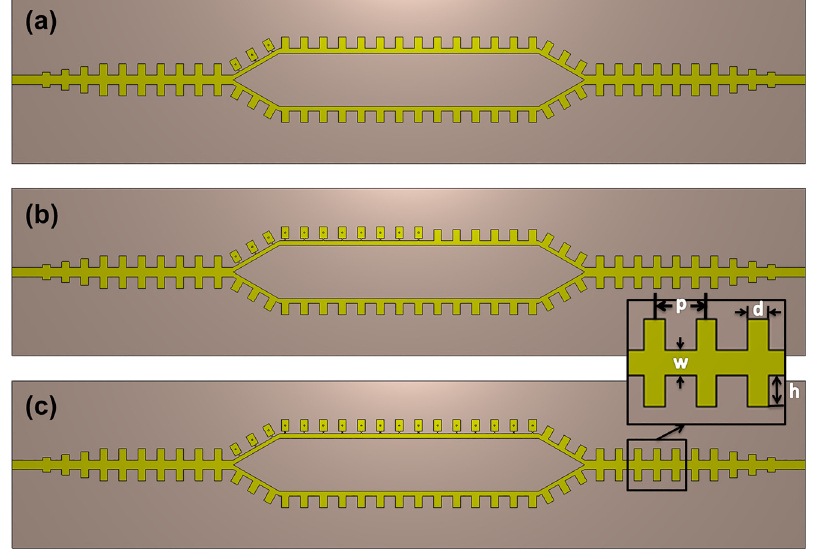
tangentis0.0009.ToachievetheimpedancematchingatMZI